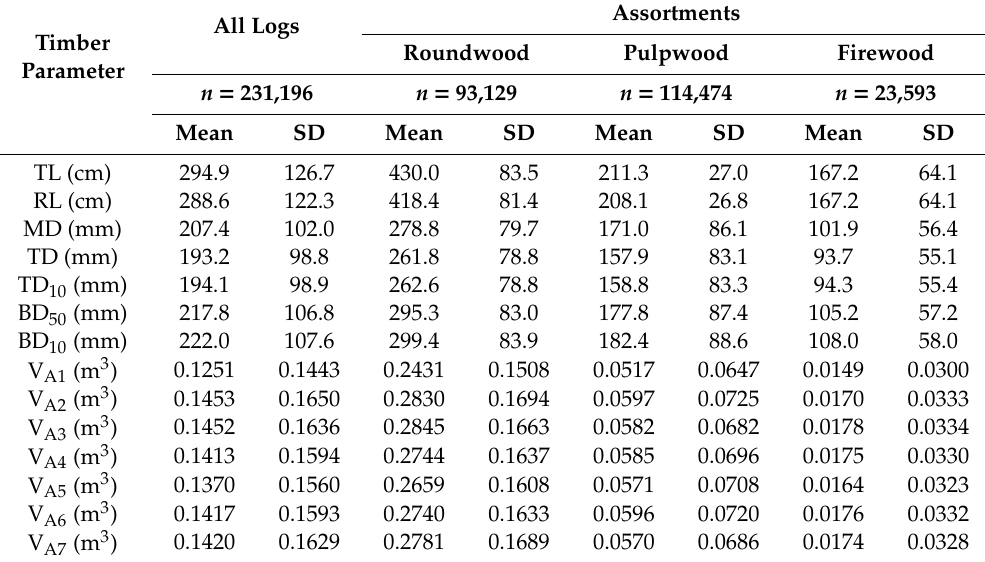
Table 2. Measured timber parameters and estimated log